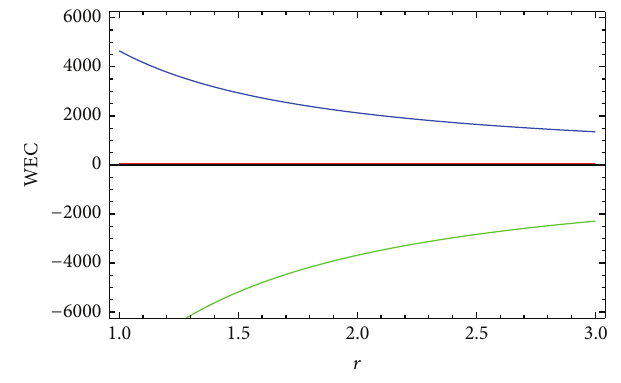
Figure 6: Plots of WEC: 𝜌 versus 𝑟 (red curve), 𝜌+𝑝 𝑟 versus 𝑟 (green curve), and 𝜌 + 𝑝 𝑡 (blue curve) versus 𝑟 for logarithmic